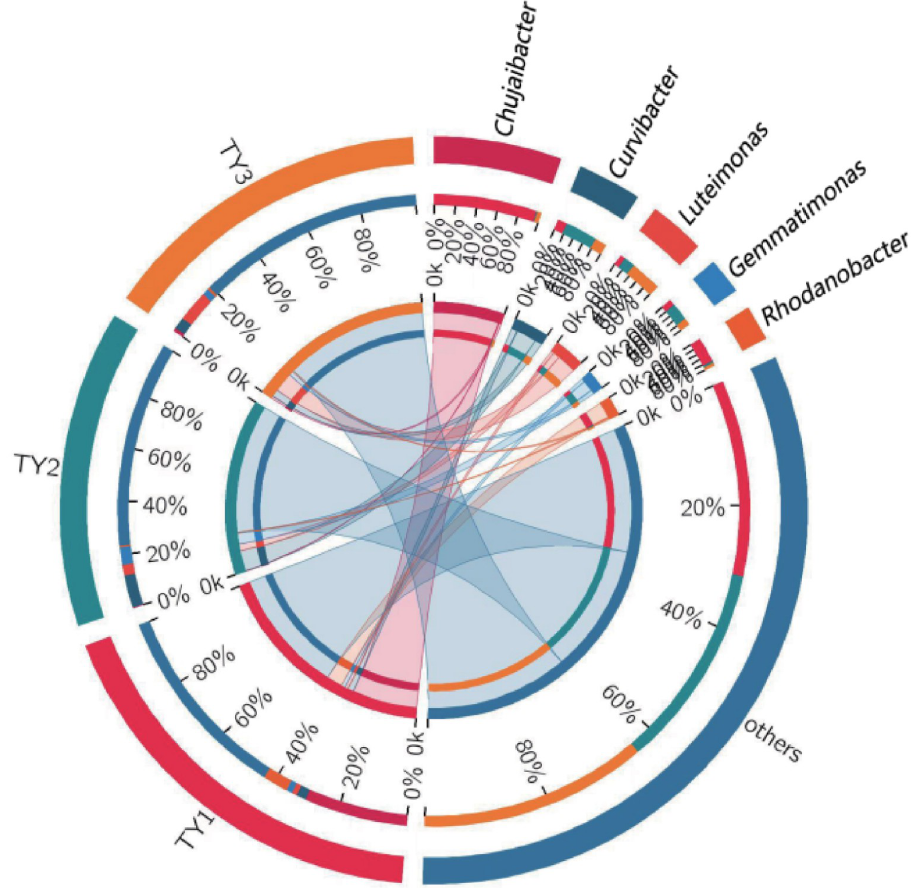
Fig 3. Profiling circles of the top five species in the different sample genera classification levels. TY1, Tomato continuous cropping; TY2, Eggplant-tomato rotation; TY3, Arrowhead-tomato rotation. In the graph of collinearity between samples and species, the left semicircle represents the species abundance composition of samples, and the right semicircle represents the distribution proportion of species in different samples under this clustering level.